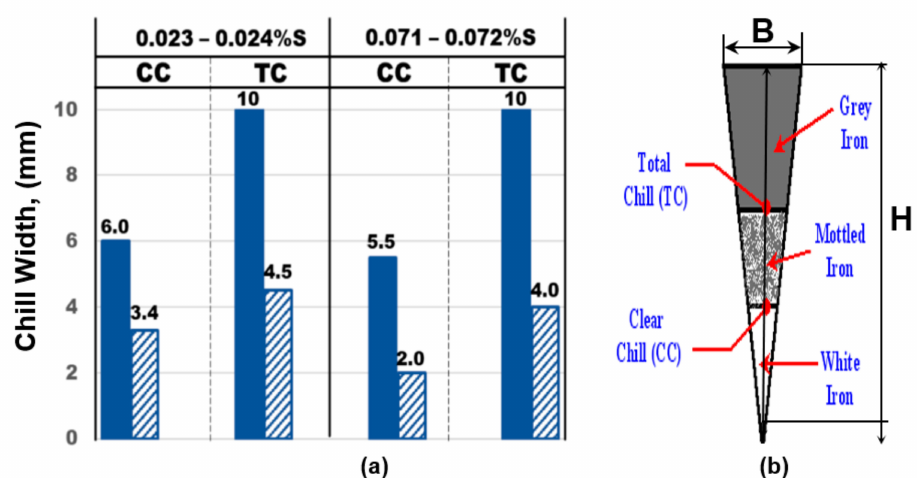
Figure 3. The influence of sulphur content of base iron on the chill sensitiveness of un-inoculated (UI) and Ca-FeSi inoculated grey cast irons ( a ), such as clear chill (CC) and total chill (TC), on the wedge casting evaluation ( b